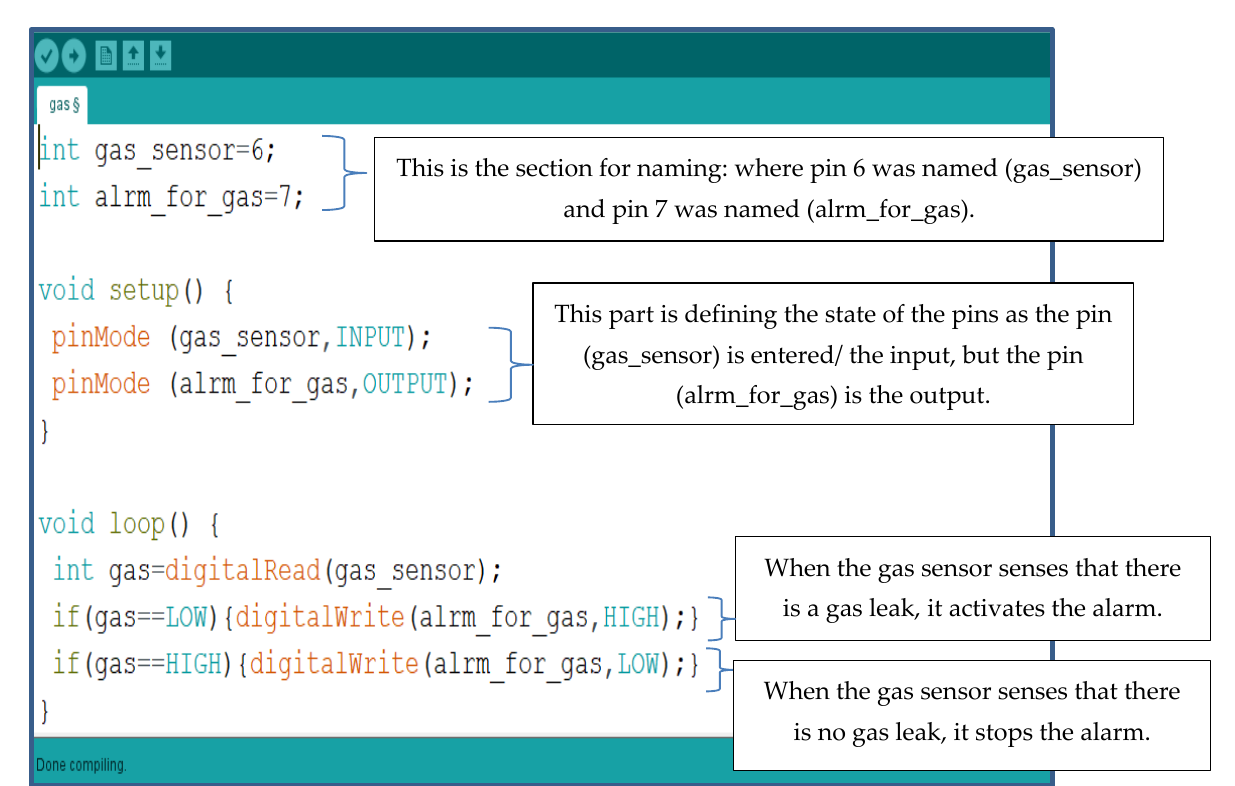
Figure A8. The implemented code for the toxic gas leak system.